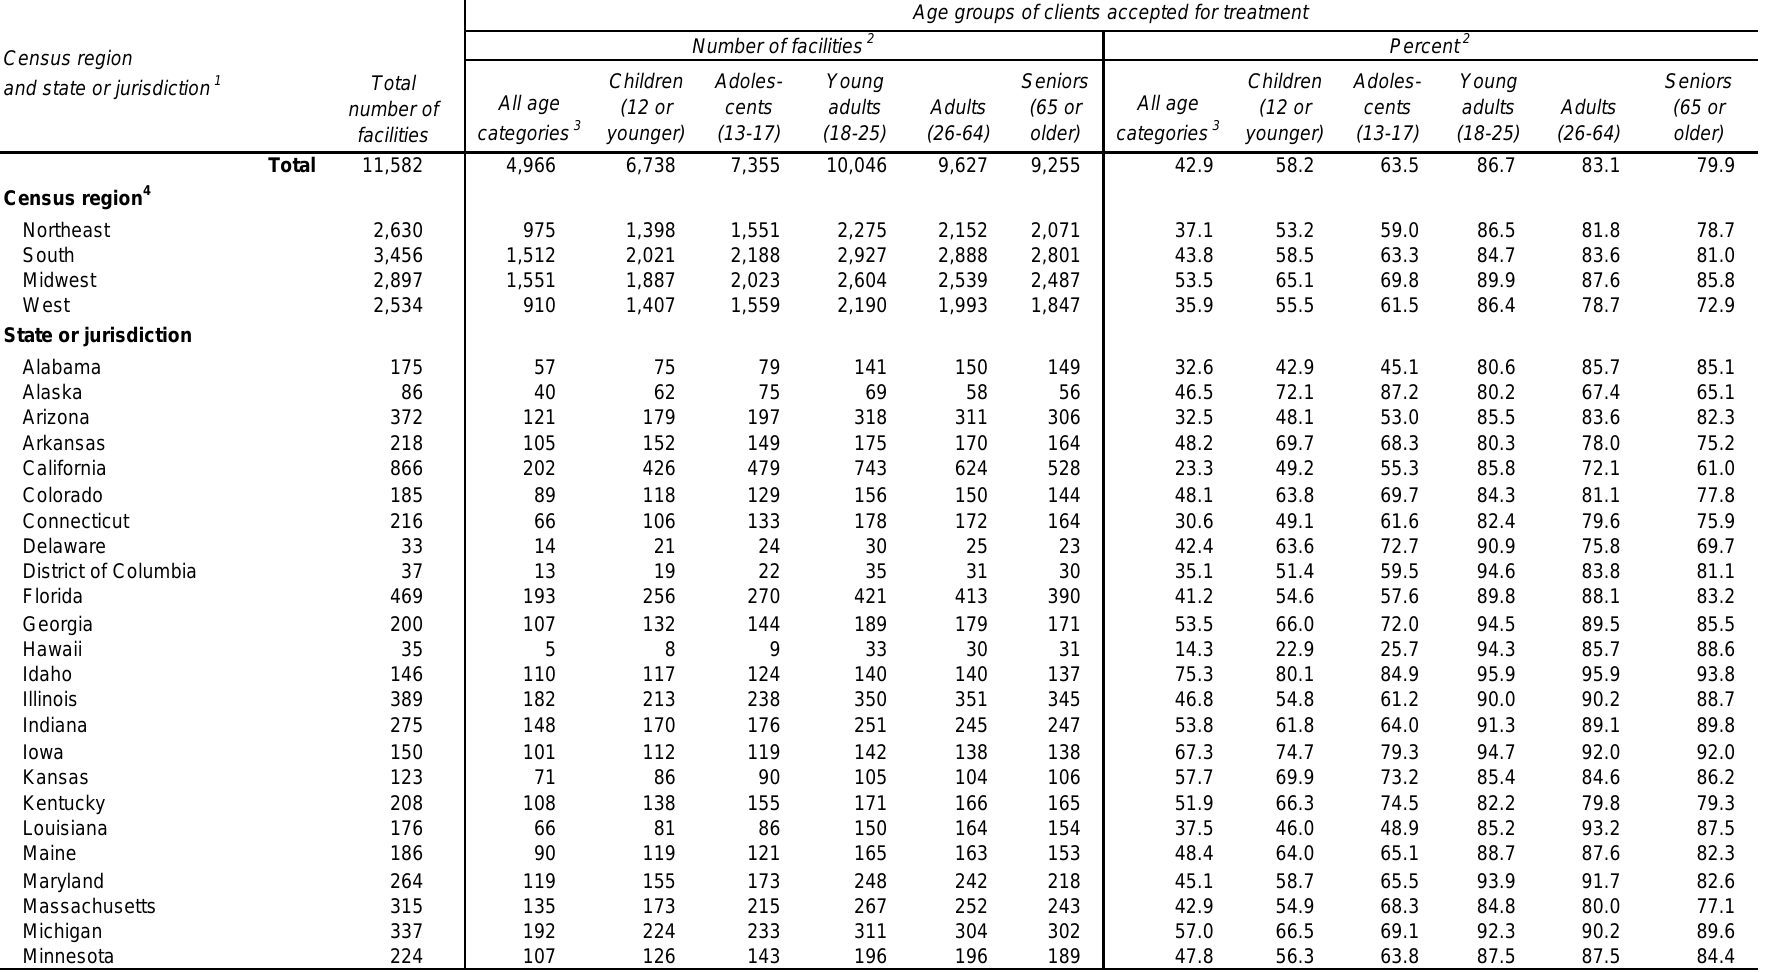
Table 3.9. Mental health treatment facilities accepting specific age groups for treatment, by Census region and state or